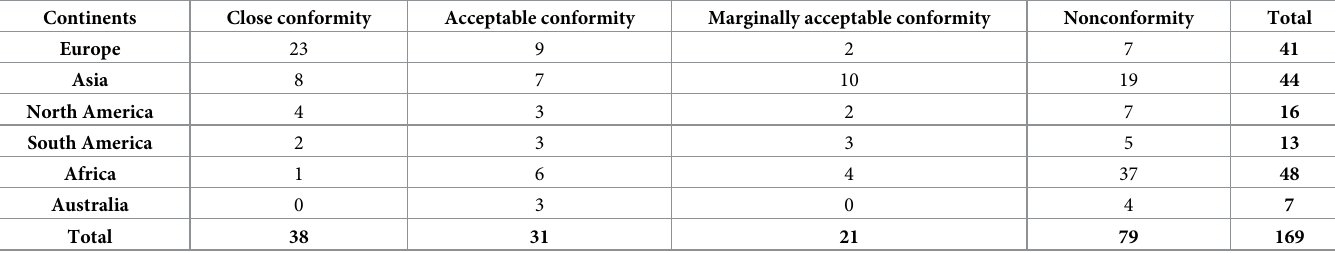
Table 1. Statistics by continents for conformity with Benford in distributions of 3D socio-geo mutual distances. Continents